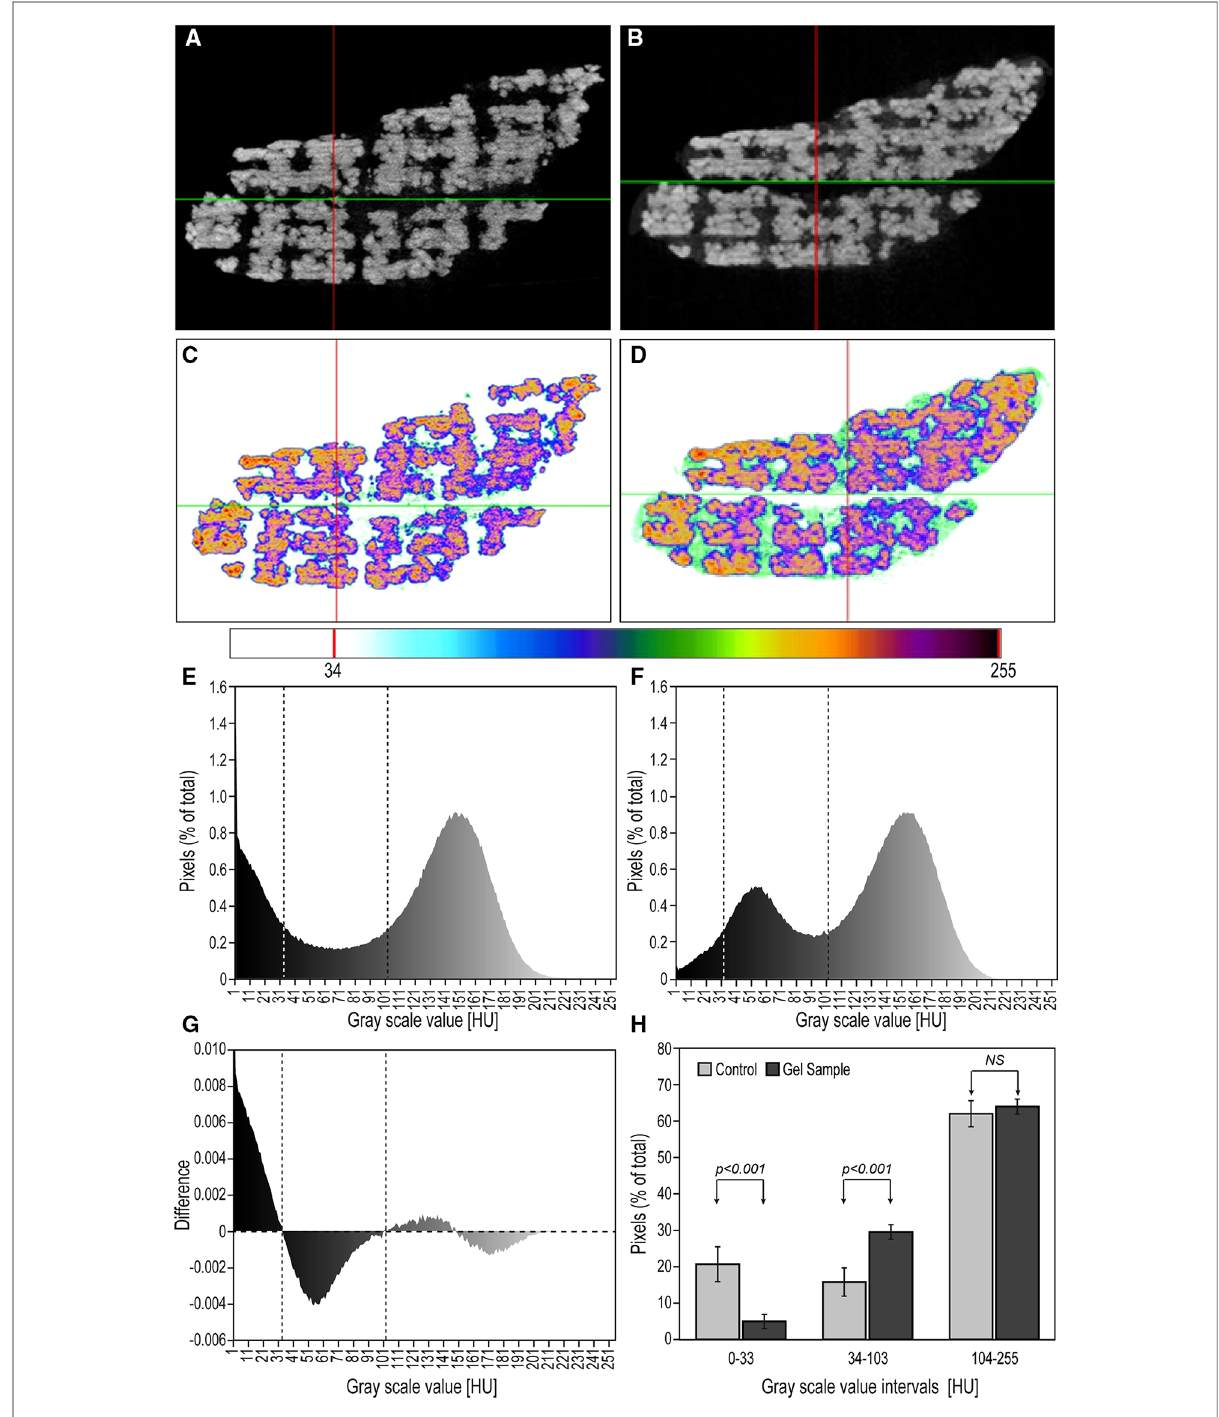
FIGURE 6 Assessment of hydrogel penetration within pores. ( A,B ) Gray-scale images of the micro-CT scans of non-crosslinked and CaCl 2 -crosslinked cores, respectively (light gray hue in the pores indicates gel presence). ( C,D ) Inverted-color images of the micro-CT scans of non-crosslinked and cross- linked cores (greenish/azure color represents the hydrogel). ( E,F ). Histograms of the number of pixels per gray scale value in empty ( E ) and gel- fi lled ( F ) reconstructed, comparable, sagittal micro-CT cross sections (vertical lines taken from G ). ( G ) Histogram of the difference in pixel frequency between ( E ), and ( F ) as dependent on their grayscale distribution, which identi fi es three regions: empty pores (left), gel-occupied pores (center) and bioceramic-occupied area (right). ( H ) Bar graphs of the average (±SD) pixel numbers in the three regions identi fi ed in ( G ) ( n